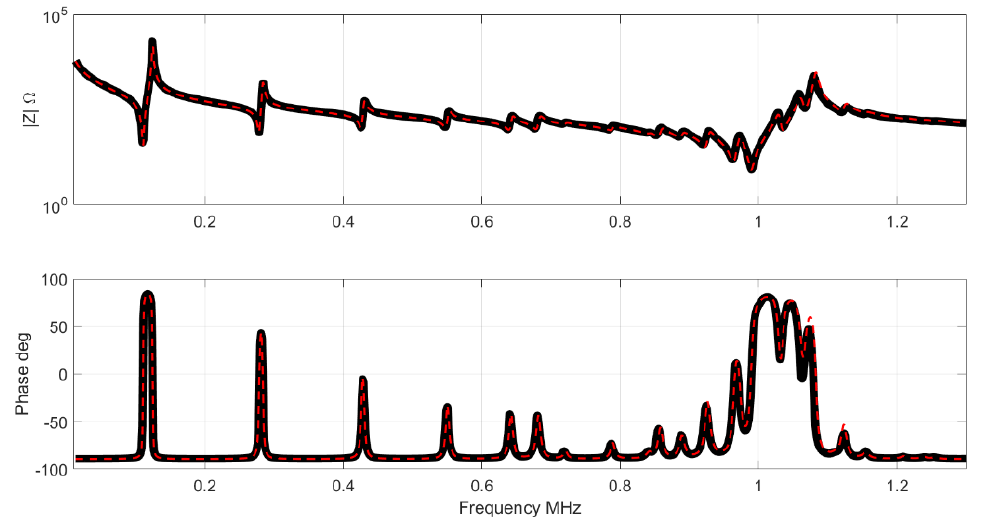
Figure 7. Results Impedance for the full set. The black curve is the impedance of the Test set, the red curve is the NN result.